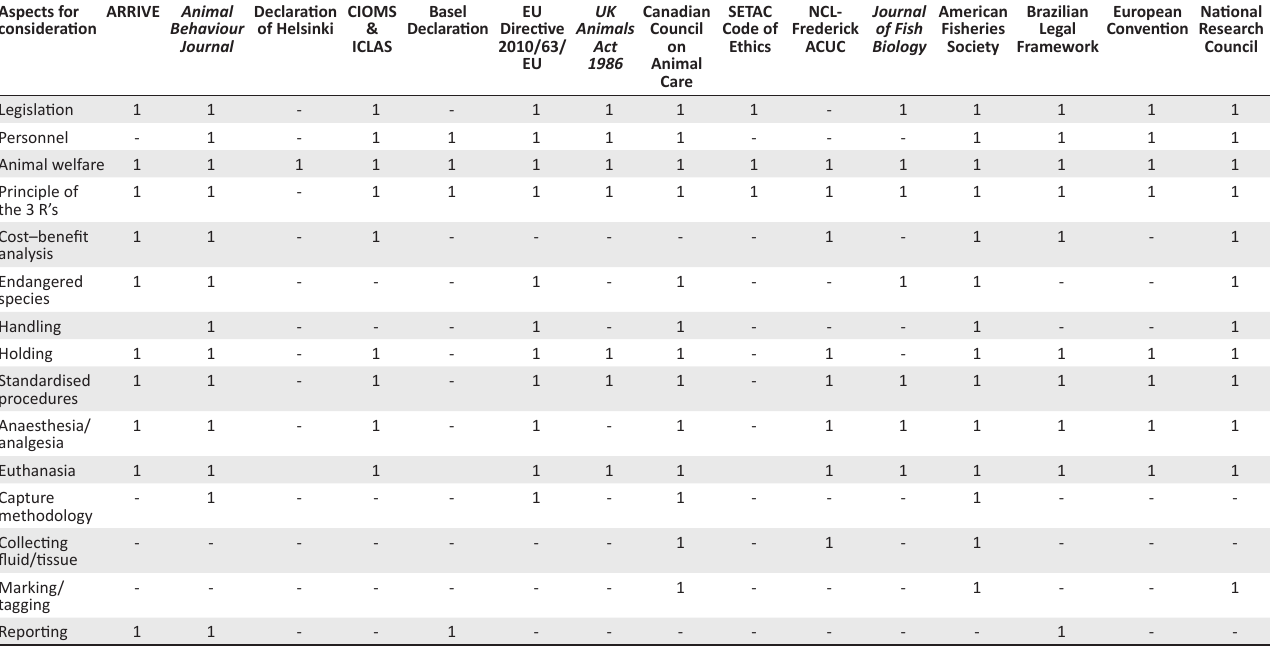
TABLE 2: Common aspects for consideration for the ethical treatment of animals in research, mentioned in the guiding documents identified in the author guidelines of 45 ISI-rated journals that publish primary research on fishes, as well as in numerous animal care and use guiding documents and national policies. Aspects for ARRIVE Animal consideration